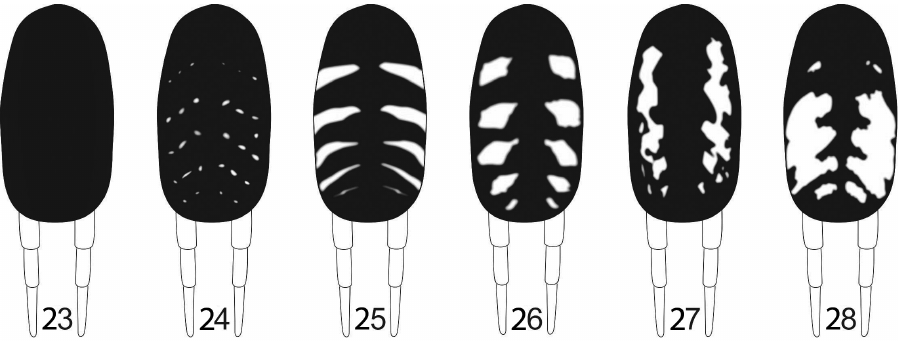
Figures 23–28. Drawings of color pattern types of the dorsum of the abdomen in Diplura species: 23 Type I 24 Type II 25 Type III 26 Type IV 27 Type V 28 Type